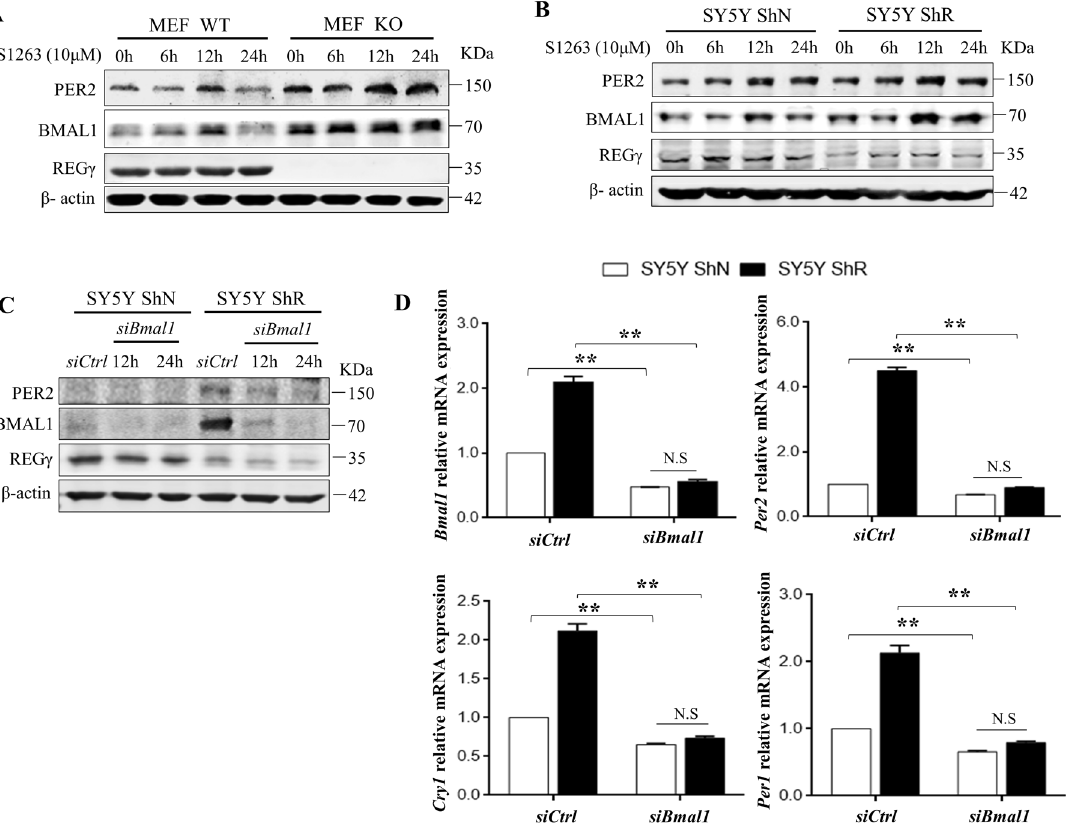
Fig. 5 Alteration of circadian physiology induced by REG γ abrogation is GSK-3 β -BMAL1 dependent. A , B MEF WT/KO and SY5Y ShN/ShR cells were treated with GSK-3 β inhibitor (S1263, 10 μ M) for the indicated time points followed by western blot analysis. C Expression of BMAL1 and PER2 levels following BMAL1 knockdown. D The mRNA expression of circadian genes Per1 , Per2 , Cry1 , and Bmal1 by real-time qPCR analysis in SY5Y ShN/ShR cells after the inhibition of Bmal1 by si-RNA. The data were signi fi ed as mean ± SD. ** p < 0.01; t test, si Bmal1 vs. control, ShN vs. ShR.